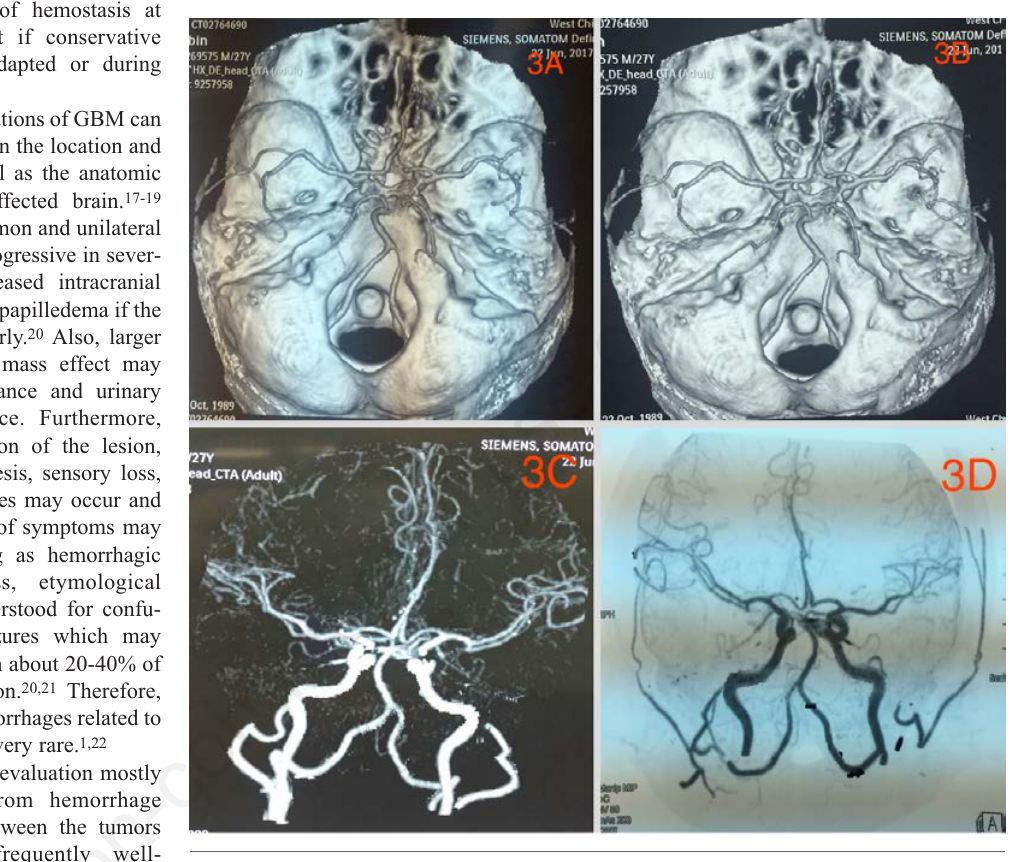
Figure 3. CT-angiography showing no vascular abnormalities.